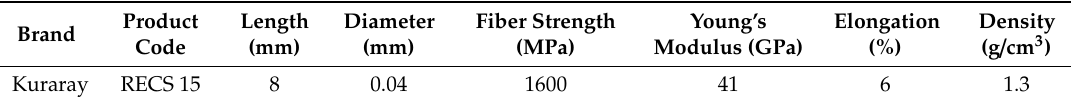
Table 4. Properties of micro-PVA fiber.